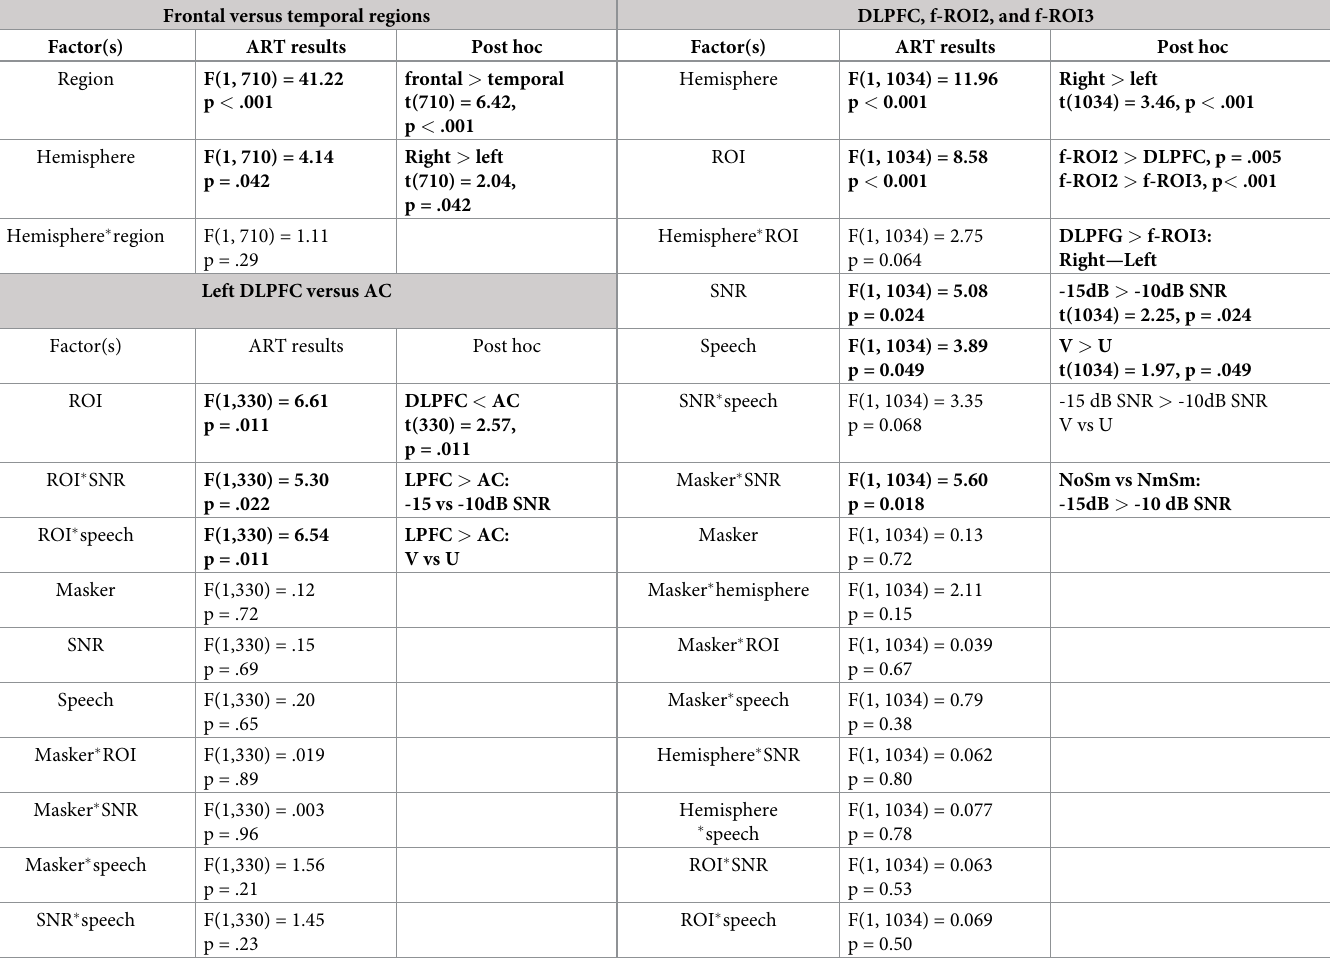
Table 2. Summary of results from ART tests for fNIRS measures. The left and right sides summarize the results related to our primary and secondary research ques- tions, relatively. We investigated the effect of speech type by comparing unprocessed (U) versus vocoded (V) speech, and the effect of masker condition by comparing dio- tic (N o S m ) and monaural (N m S m ) conditions, the effect of SNRs (-10 and -15 dB SNR), and the interactions between them on different cortical regions. Frontal versus temporal